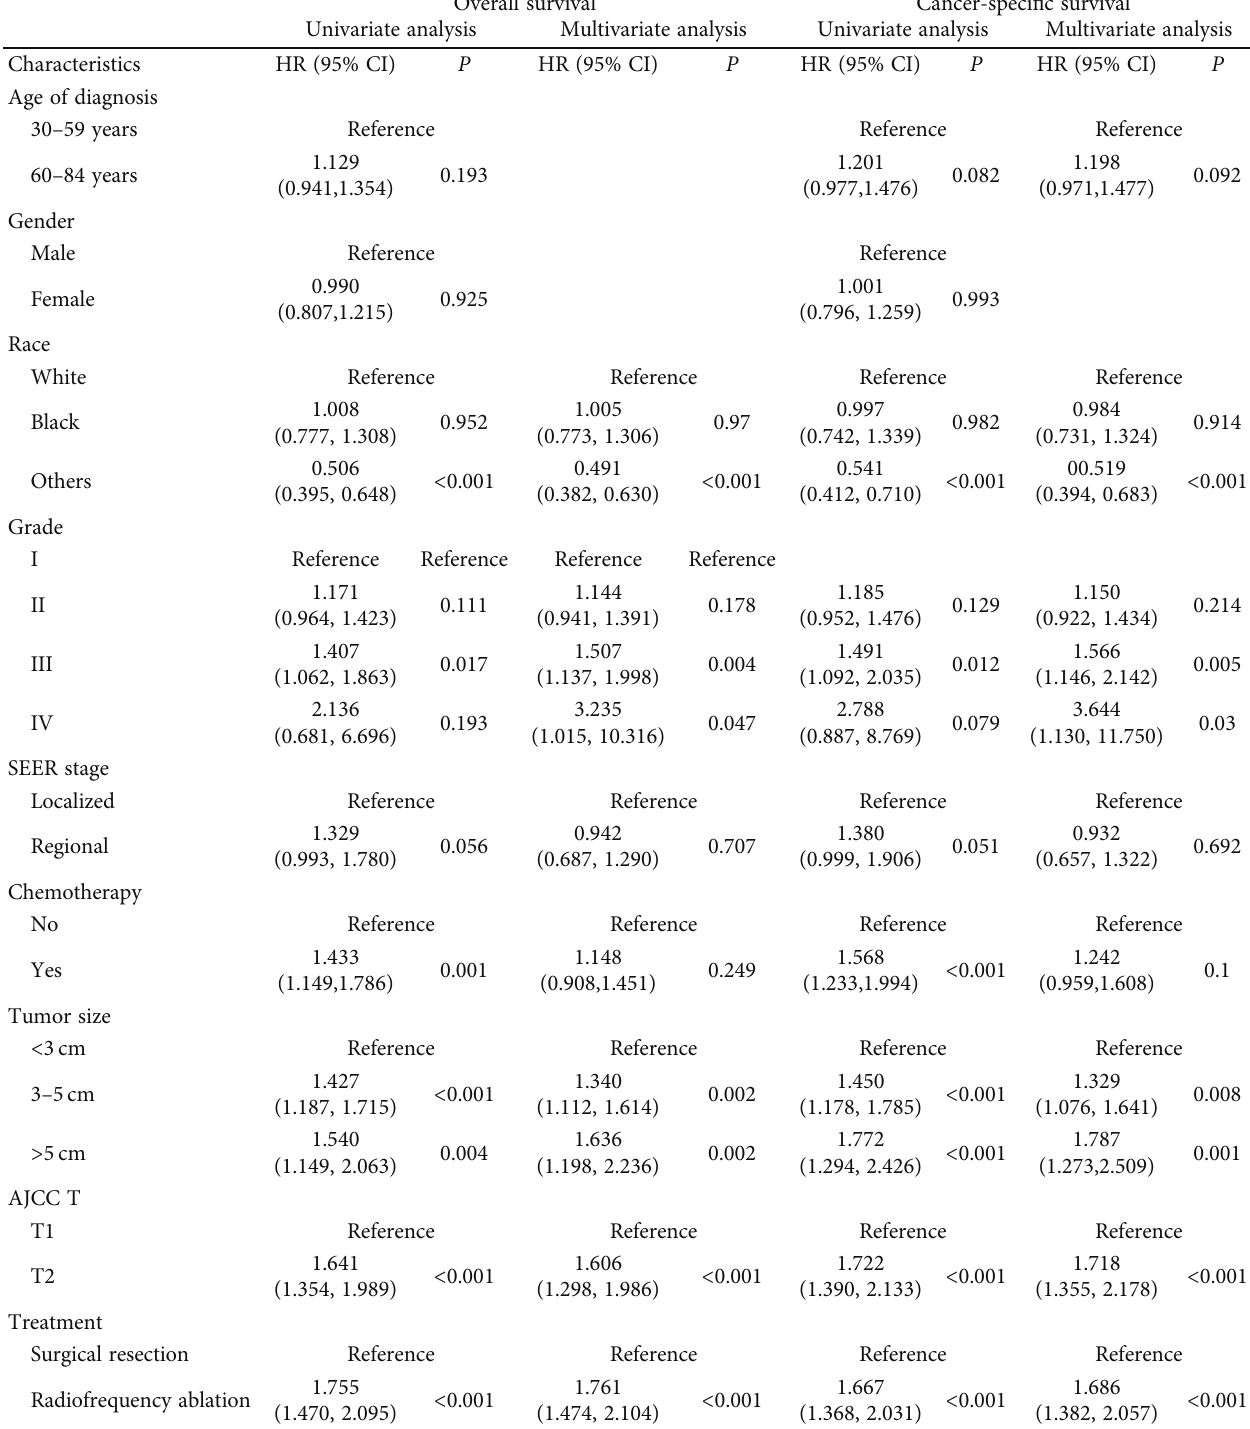
Table 3: Predictors for overall survival and cancer-speci fi c survival after